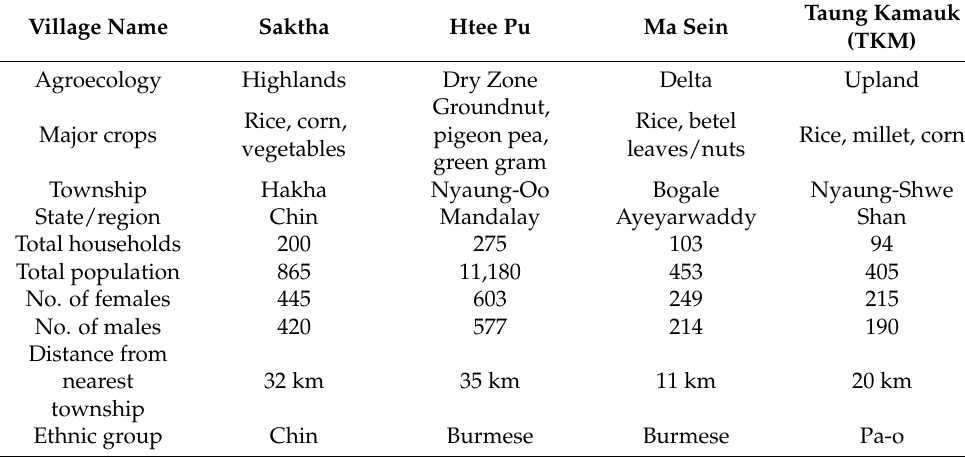
Table 1. Profile of the four climate-smart villages (CSVs) in